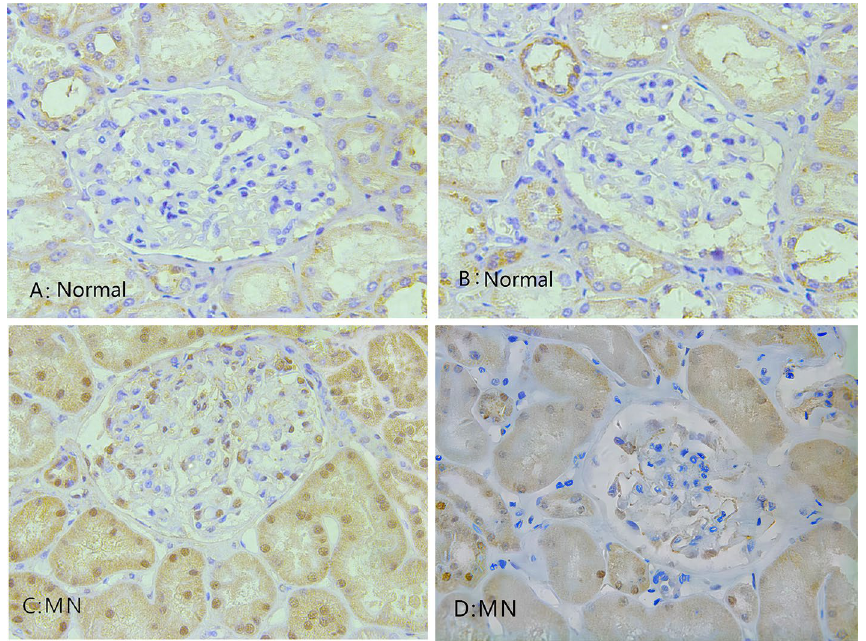
Figure 4. Expression of MIF in renal tissue (light microscope × 400). ( A , B ) MIF expression in the control group. ( C,D ) MIF expression in MN patients.